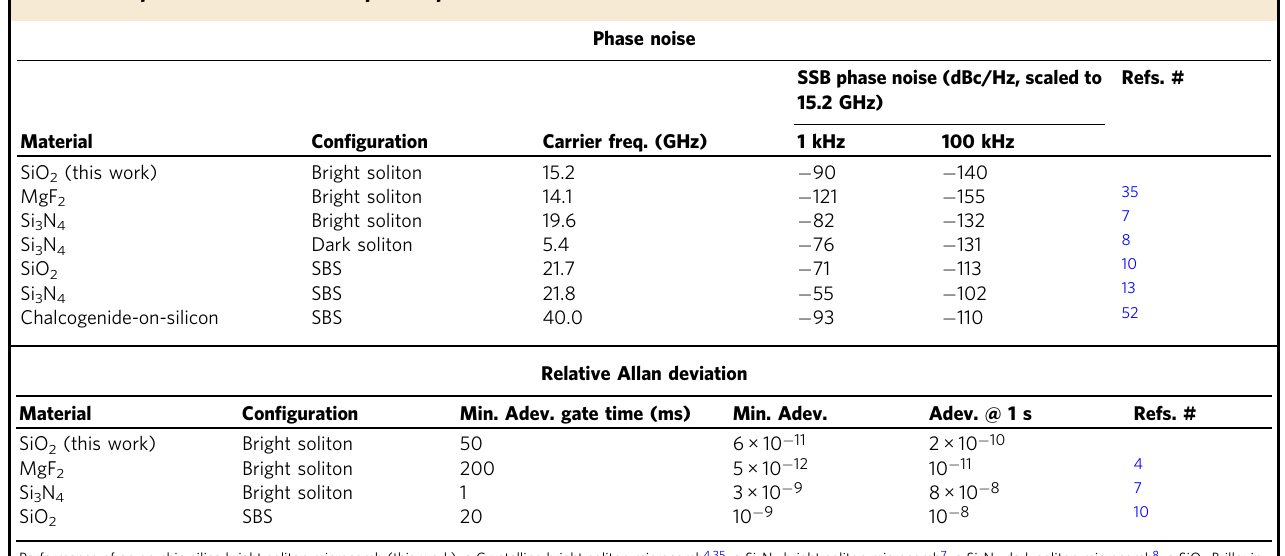
Table 1 Comparison of miniature reported photonic-based microwave oscillators.